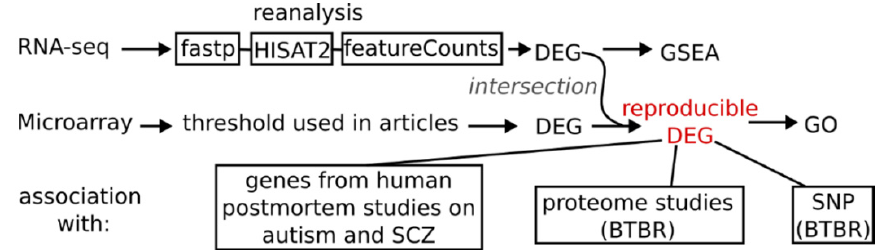
Figure 1. Basic workflow scheme. These steps were applied separately for hippocampus and cortex + striatum datasets resulting in two reproducible differentially expressed genes lists. For reanalysis of available RNA-seq data first adapters and low-quality reads were trimmed using fastp program, then aligned to mm10 genome with HISAT2 (2.2.1)software and summarized to gene counts with featureCounts (v2.0) function using genecode vM22 annotation.